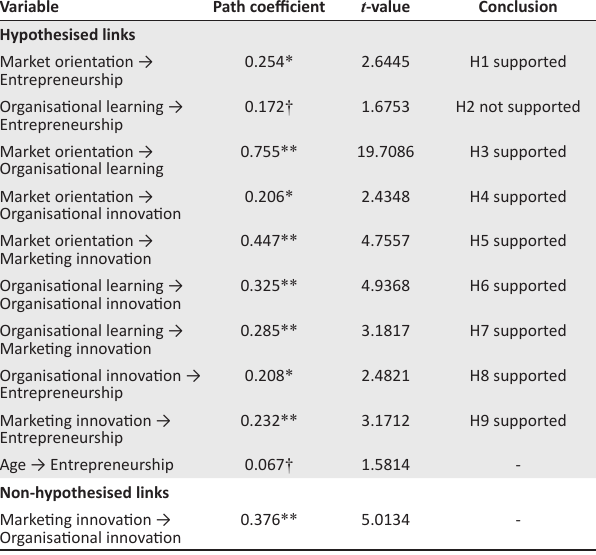
TABLE 2: Structural equation model results.